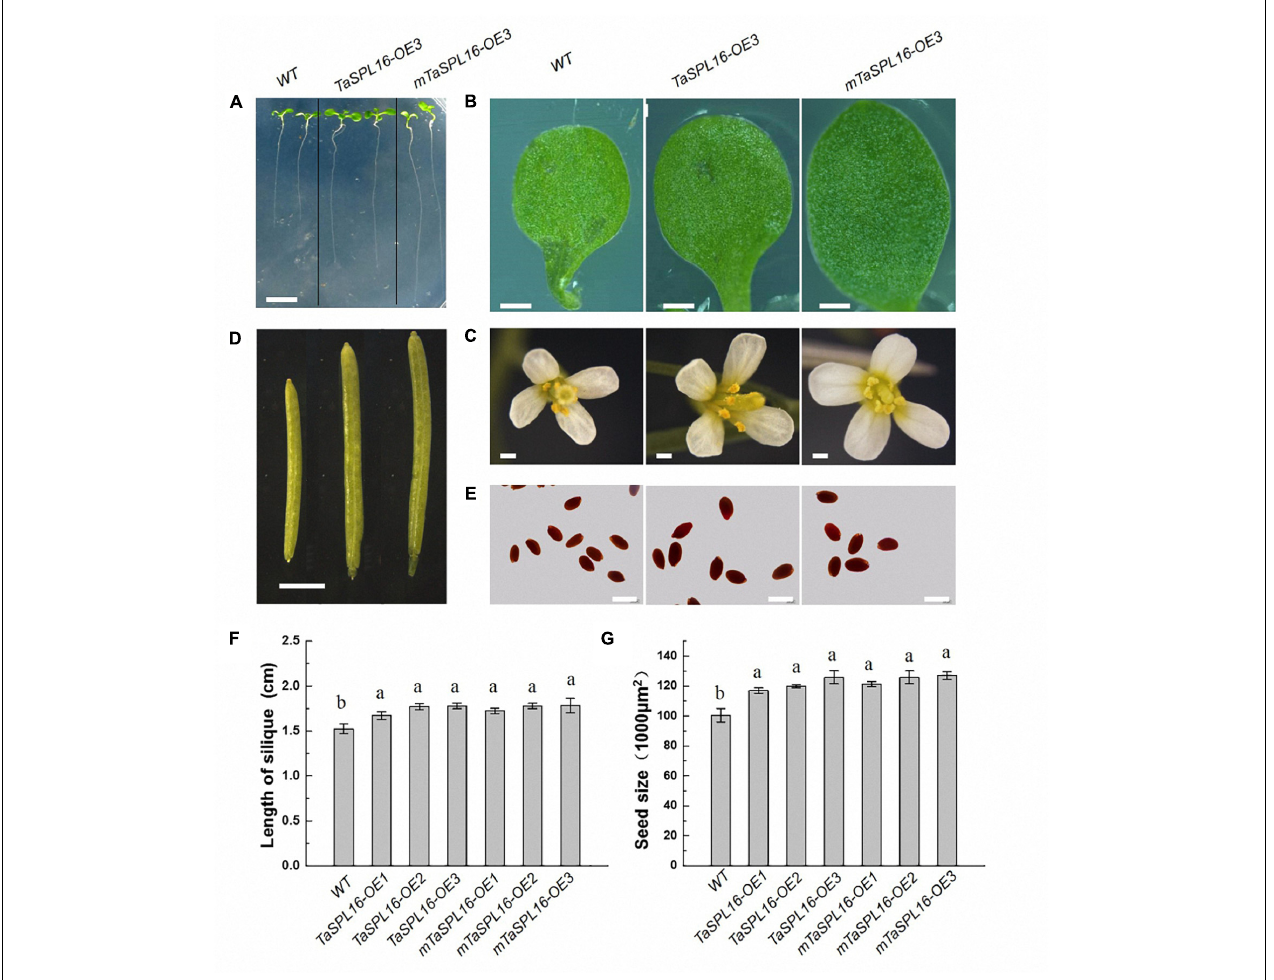
FIGURE 6 | Overexpression of TaSPL16 enlarges organs of Arabidopsis . WT, wild-type Arabidopsis ; TaSPL16-OE3 , a transgenic line expressing non-mutated TaSPL16-7B ; mTaSPL16-OE3 , a transgenic line expressing miR156-resistance mRNA of mTaSPL16-7B . TaSPL16-OE3 and mTaSPL16-OE3 are shown as representatives because similar phenotypes were observed among independent TaSPL16-OE lines or independent mTaSPL16-OE lines. (A) The roots of 7-day-old seedlings. Scale bar: 5 mm. (B) Cotyledon of 7-day-old seedlings. Scale bar: 0.5 mm. (C) Floral organs. Scale bar: 1 mm. (D) Siliques. Scale bar: 2 mm. (E) Mature seeds. Scale bar: 0.5 mm. (F,G) Comparison of silique length and seed size (represented by the projective areas of a seed) of wild-type and these transgenic plants. Data given as mean ± SD ( n = 10). Different letters at top of each column indicate a significant difference among genotypes at P < 0.05 determined by Tukey’s HSD